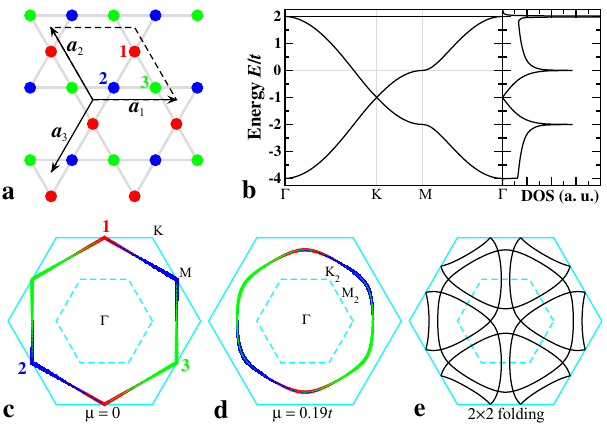
Fig. 1 | Itinerant fermions on kagomé lattice. a Lattice structure with three sub- lattices denoted by red (1), blue (2), and green (3) circles. The two basis vectors ffiffi p Þ . The reciprocal lattice vectors 3 , de fi ning the unit cell are a 1 =(1,0) and a 2 = ð(cid:1) 1 ffiffi p 2 2 Þ and b 3 1 4 π ffiffi p ð p ð 0, (cid:1) 1 Þ . The third direction follows a 3 = − a 1 − a 2 and b 1 = 4 π ffiffi 2 = 2 , 2 3 3 b 3 = − b 1 − b 2 . b Band dispersion and DOS.Fermi level atvH fi lling is marked by the greylineat μ =0. c FSatvH fi llinginthehexagonalBZ(solidcyancurves).Thickness of colored lines and numbers display the sublattice contents. The high symmetry p Þ andM= ð 0,± 2 π ffiffi p Þ , ð ± π ,± π ffiffi p Þ . d Sublattice ,0 Þ , ð ± 2 π ,± 2 π ffiffi points Γ =(0,0),K= ð ± 4 π 3 3 3 3 3 resolved FS at μ =0.19 t for electron doping above vH fi lling. Dashed cyan curves enclose the 2×2 reduced BZ with the resulting high symmetry points denoted by K and M 2 = 1 M. e FS in ( d ) folded by the 2×2 BZ K 2 = 1 2 2